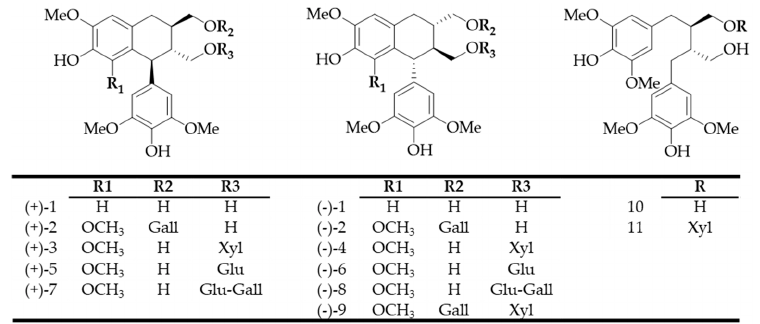
Figure 1. Chemical structures of lignans 1 – 11 . Xyl, Glu, and Gall correspond, respectively, to β - xylopyranose, β -glucopyranose, and galloyl. β -xylopyranose, β -glucopyranose, and galloyl. Molecules 2019 , 24 , x